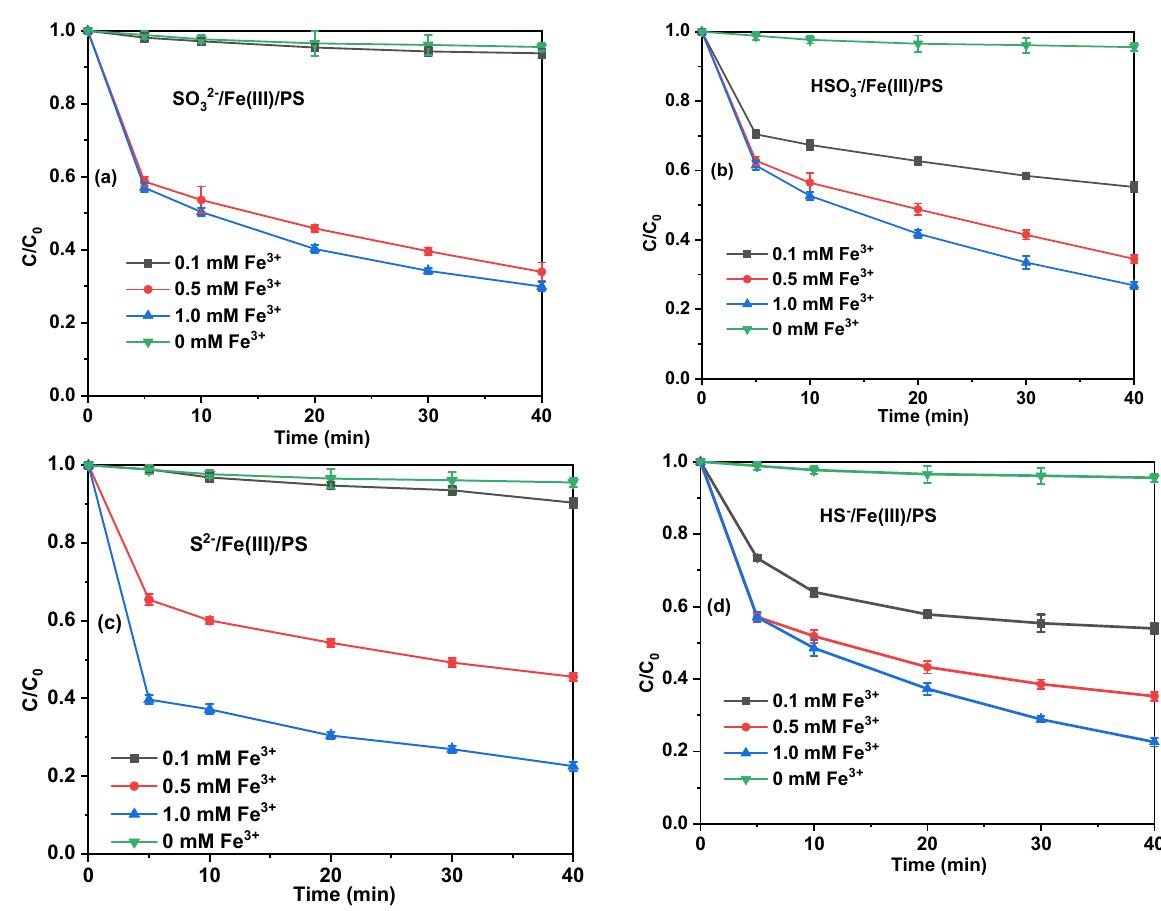
S(IV)/Fe(III)/PS and S(-II)/Fe(III)/PS system.